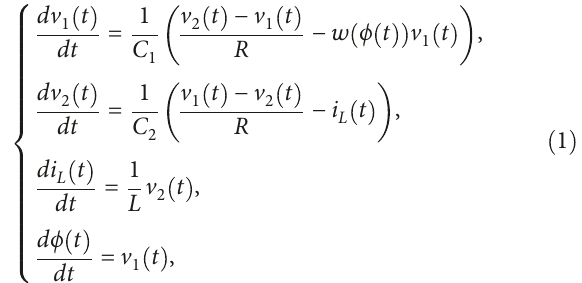
Figure 1: The memristor-based chaotic Chua ’ s